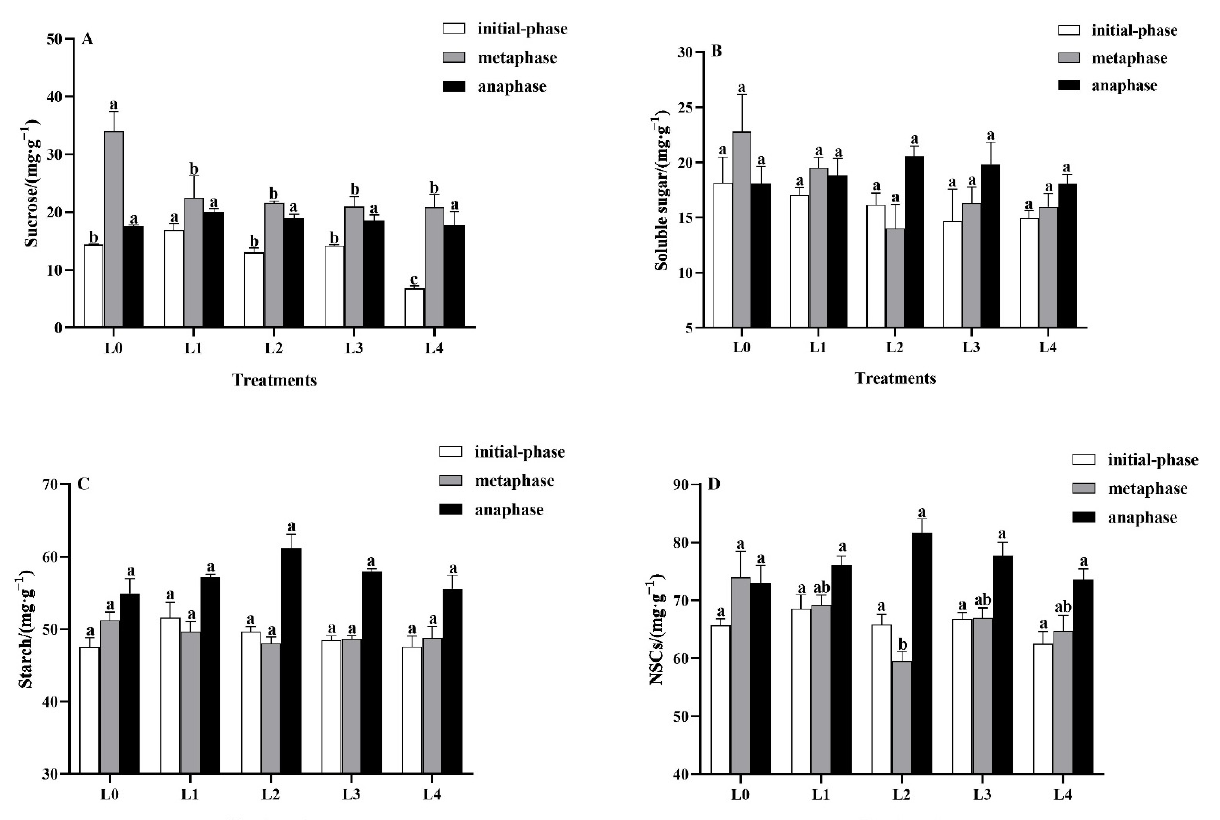
Figure 5. Effects of different light intensities on leaf carbohydrate contents of Ma bamboo that include ( A ) sucrose, ( B ) soluble sugar, ( C ) starch, and ( D ) NSCs. Note: L0, L1, L2, L3, and L4 refer to 100%, 40%, 30%, 20%, and 10% of natural light, respectively. Values are the means ± SE of four replicates per treatment. Different letters indicate significant differences between treatments at the same shooting period ( p < 0.05).